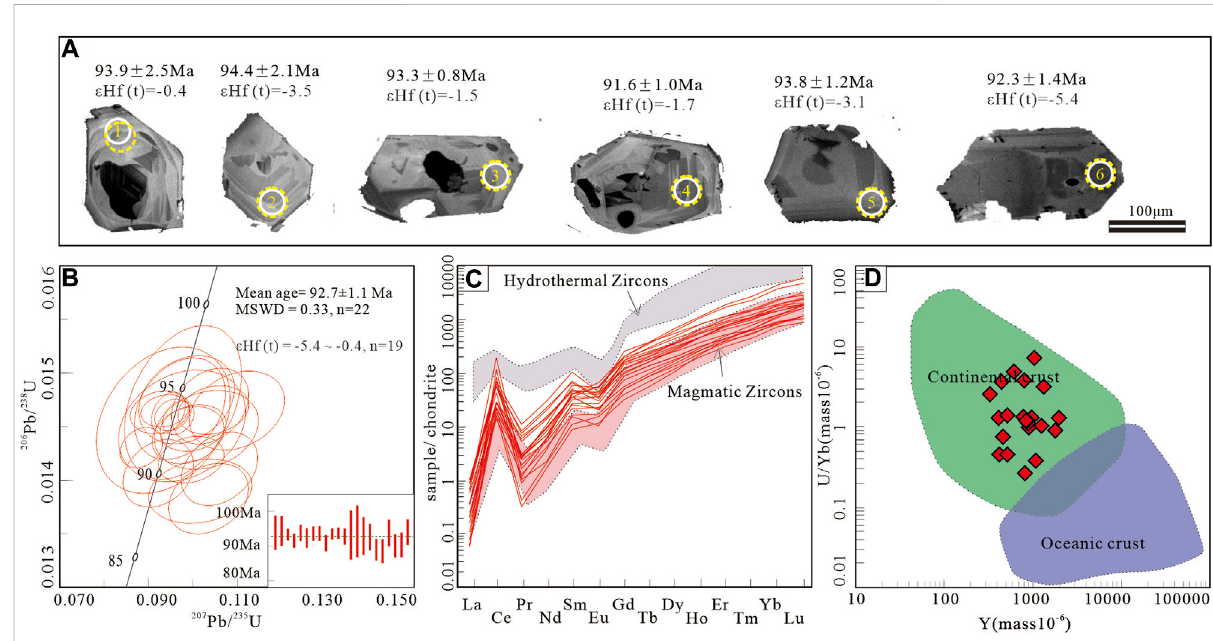
FIGURE 5 Diagrams of Zircon U-Pb geochronology. (A) Cathodoluminescence (CL) images of representative zircon grains; (B) zircon U-Pb concordia diagrams and weighted mean ages; (C) chondrite-normalized REE patterns of zircons (based on Hoskin, 2005); and (D) discriminant diagrams with differentcry stallization setting zircon fi elds (base on Grimes etal et al., 2007) for the Xiabie Co granite.